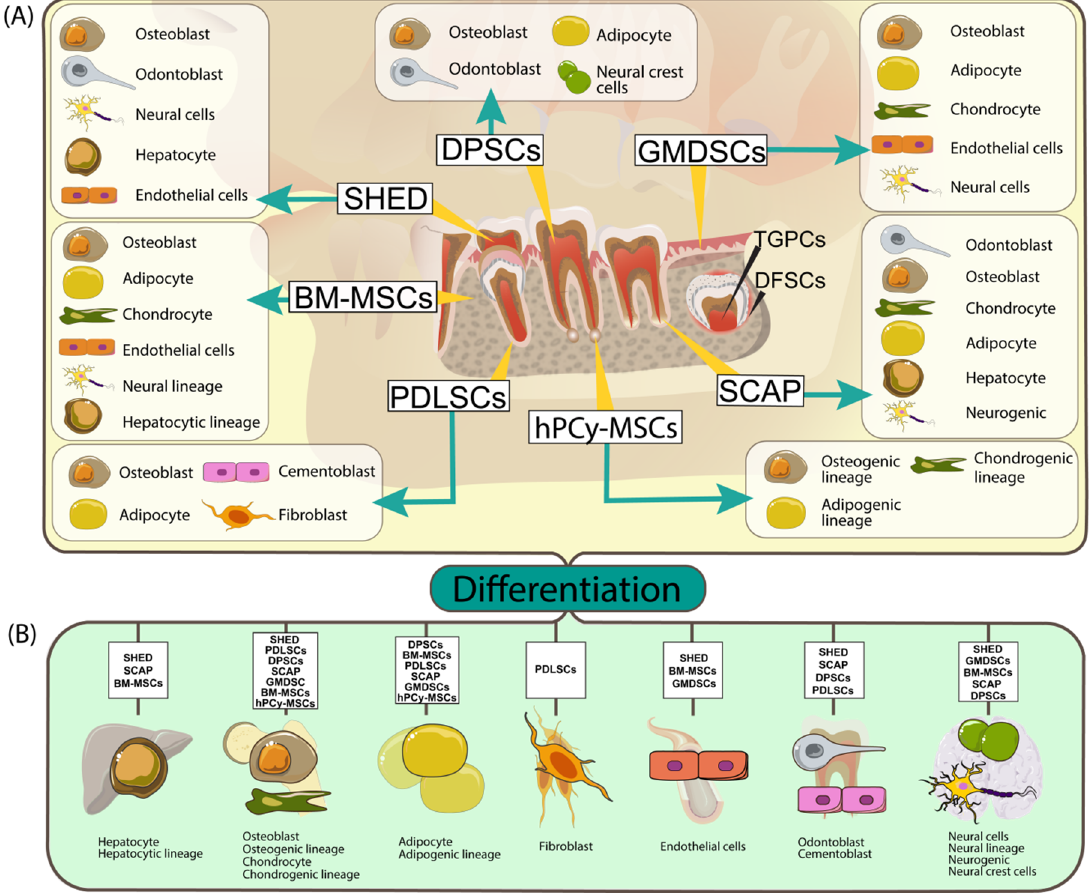
Figure 1. ( A ) Summary of dental stem cells types, sources and their multilineage differentiation capability (BM-MSCs: bone marrow mesenchymal stem cells; DPSCs: human dental pulp stem cells; SHED: human exfoliated deciduous teeth; PDLSCs: periodontal ligament stem cells; SCAP: stem cells from apical papilla; GMDSC: gingival-mesenchymal derived stem cells, hPCy- MSCs: human periapical cyst-mesenchymal stem cells). The yellow trace lines indicate stem cells origin and the arrows pinpoint their possible differentiation outcome; ( B ) Through specific environment conditions and different growth factors the dental stem cell types can be differentiated into other cell types (adipocytes, epithelial cells, hepatocyte, and so on).